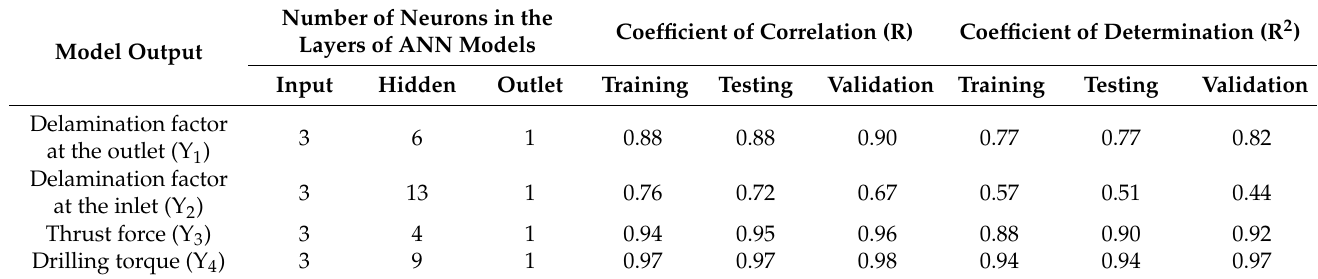
Table 4. The structure of ANN models and the performance criteria during the development and validation phase.